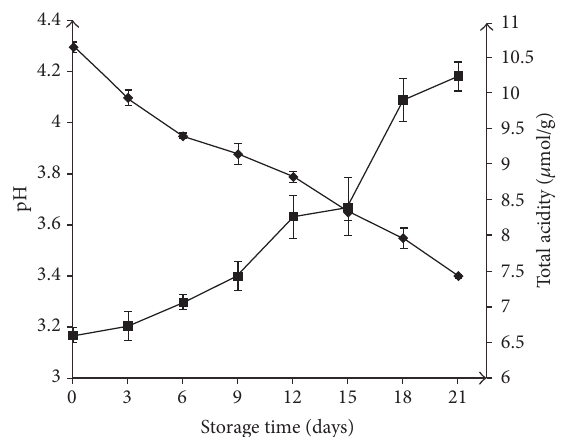
Figure 5: Effect of storage time on the pH ( X ) and the total acidity ( ◼ ) of fermented